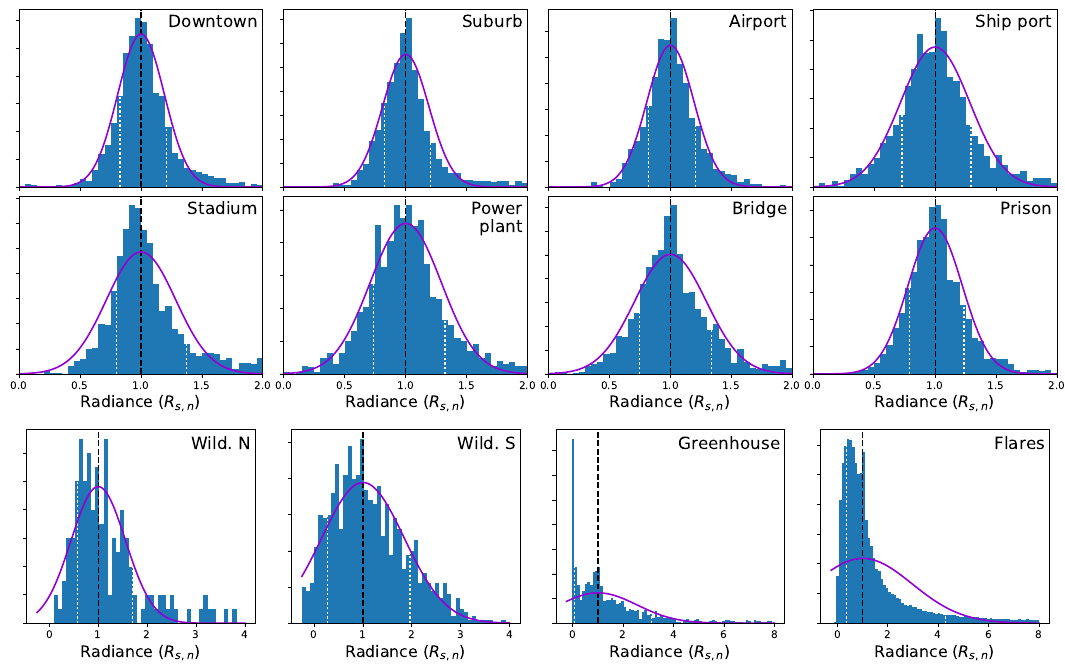
Figure 3. Radiance relative to the site median ( R s , n ) for all sites and months within each given class. The curve shows a normal distribution based on the data, but is not a fit (see text). The dotted white lines show the location of the 15.9th and 84.1th percentile. The wilderness class was divided into wilderness areas in Alaska (Wild. N) versus in the contiguous US states (Wild. S). Note that the horizontal axis of the bottom four panels covers larger ranges than the top eight